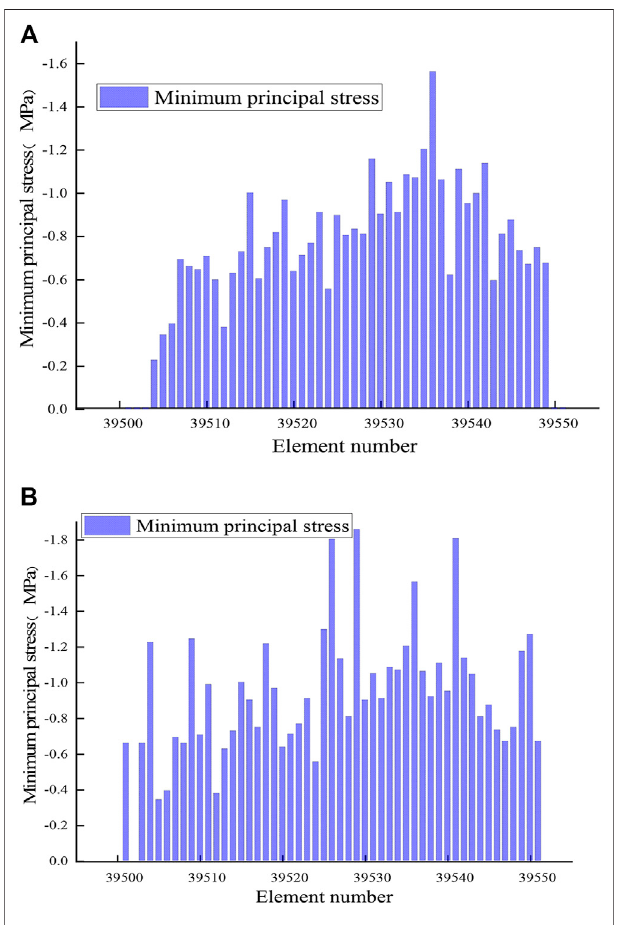
FIGURE16| Stresslevelsbetweencracks. (A) S/T=1.25distribution of minimum principal stress between cracks, (B) S/T = 2.5 distribution of minimum principal stress between cracks, (C) S/T = 3.75 distribution of minimumprincipalstressbetweencracks,and (D) S/T=5distribution of minimum principal stress between